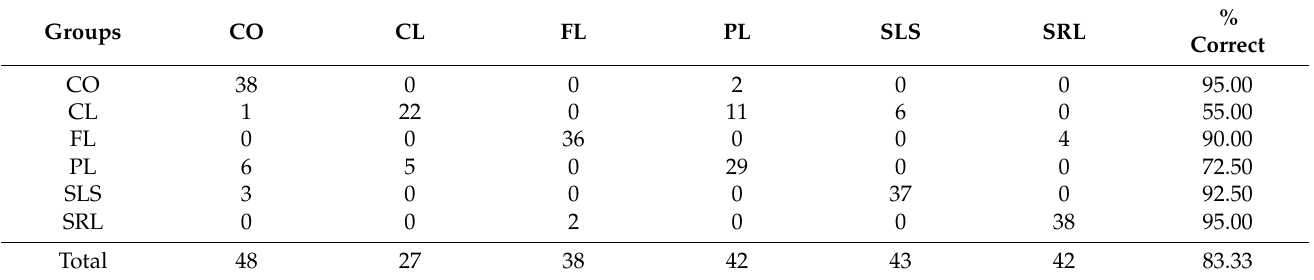
Table 4. Classification matrix of six lithological units (CO, CL, FL, PL, SLS, SRL).